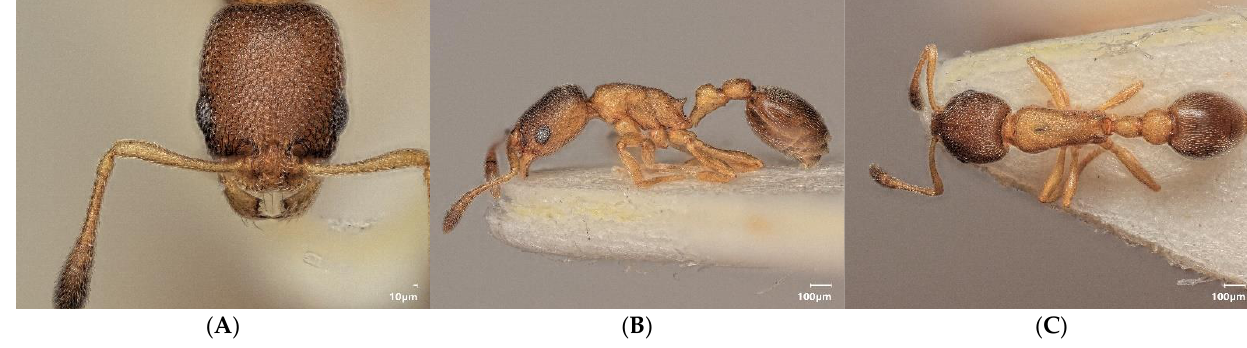
Figure 3. Cardiocondyla goa, holotype: head in dorsal view ( A ), lateral view ( B ), dorsal view ( C ).